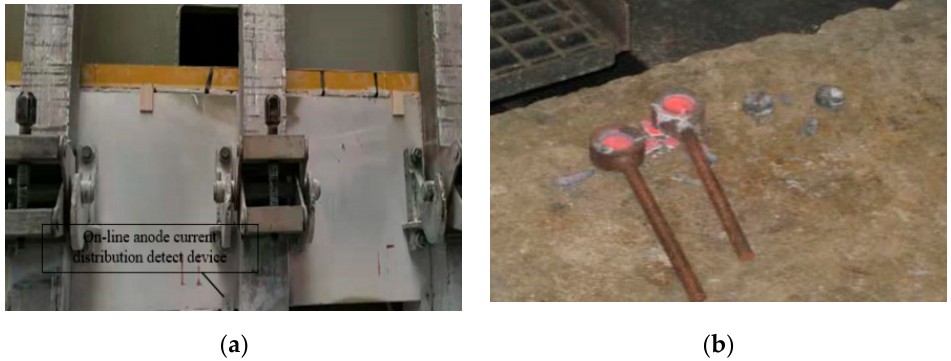
Figure 9. In situ data collection: ( a ) online collection of anode current distribution in aluminum reduction cell; ( b ) alumina concentration sampling for inspection.